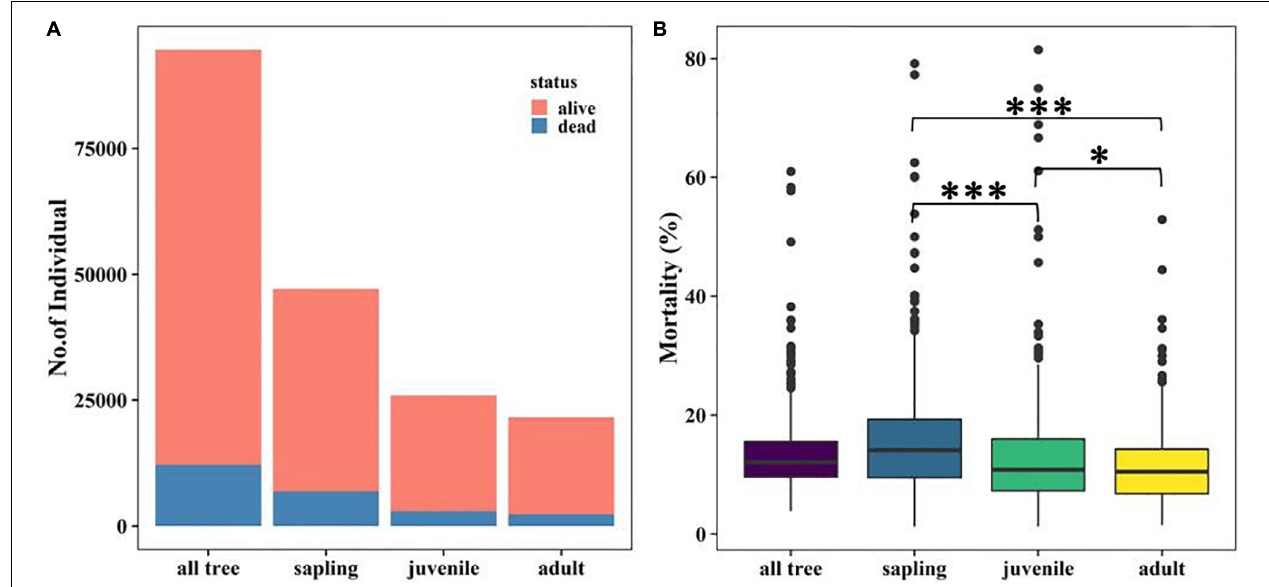
FIGURE 2 | Tree abundance (A) and mortality (B) at different life stages. The significant effect of Wilcoxon signed-rank test is indicated by ∗ P < 0.05, ∗∗ P < 0.01, and ∗∗∗ P <